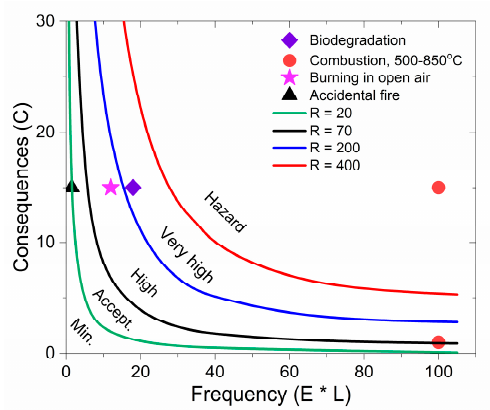
Figure 5. Qualitative risk assessment: consequences vs. frequency of occurrence of GNP and MWCNT exposure, related to four scenarios at the end-of life of 3 wt. % GNP/MWCNT/PLA packaging films: biodegradation, combustion, burning and accident fire. Risk is estimated for 100 kg nanocomposite wastes.